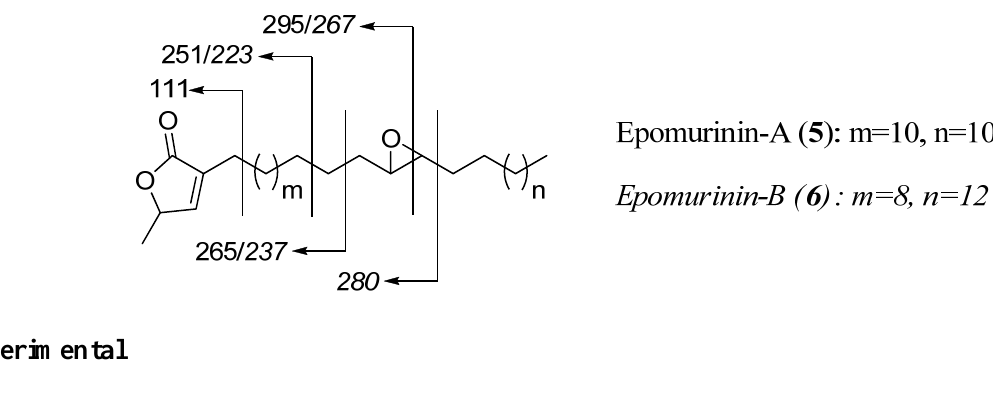
Figure 4. Key EI-MS fragmentation of ACGs ( 5 + 6